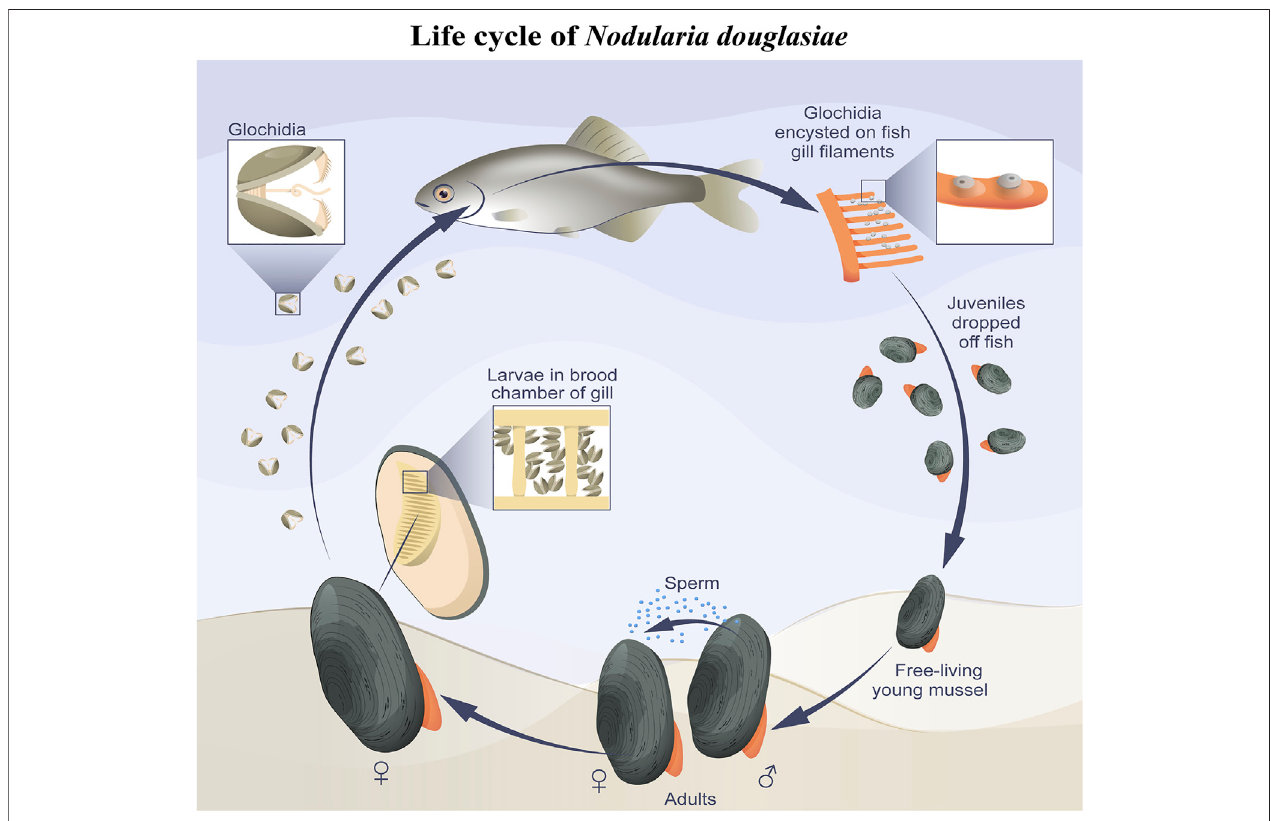
FIGURE 9 | Simpli fi ed scheme of N. douglasiae life cycle. The main host fi sh is Amur bitterling Rhodeus sericeus .